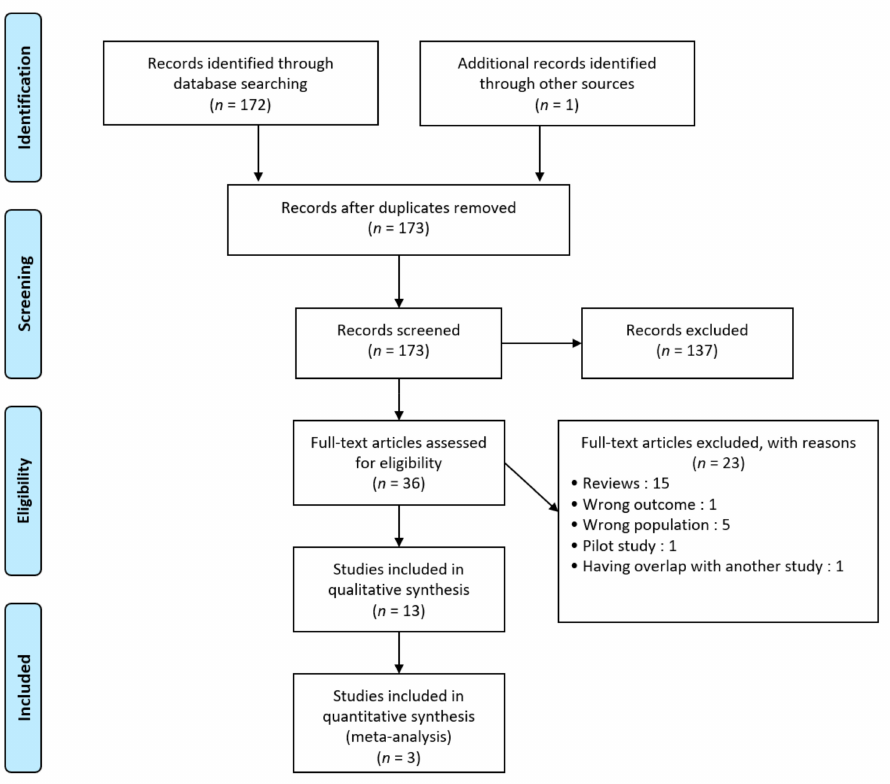
Figure 1. Preferred reporting items for systematic reviews and meta-analyses (PRISMA)